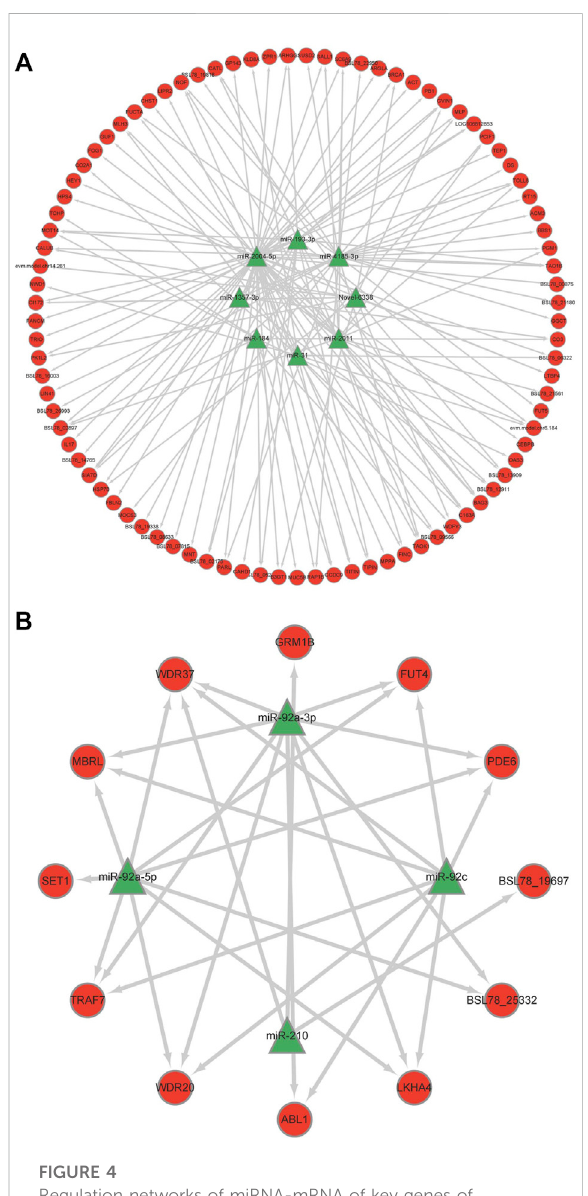
FIGURE 4 Regulation networks of miRNA-mRNA of key genes of correlation analysis. (A) Down-up mode; (B) Up-down mode.